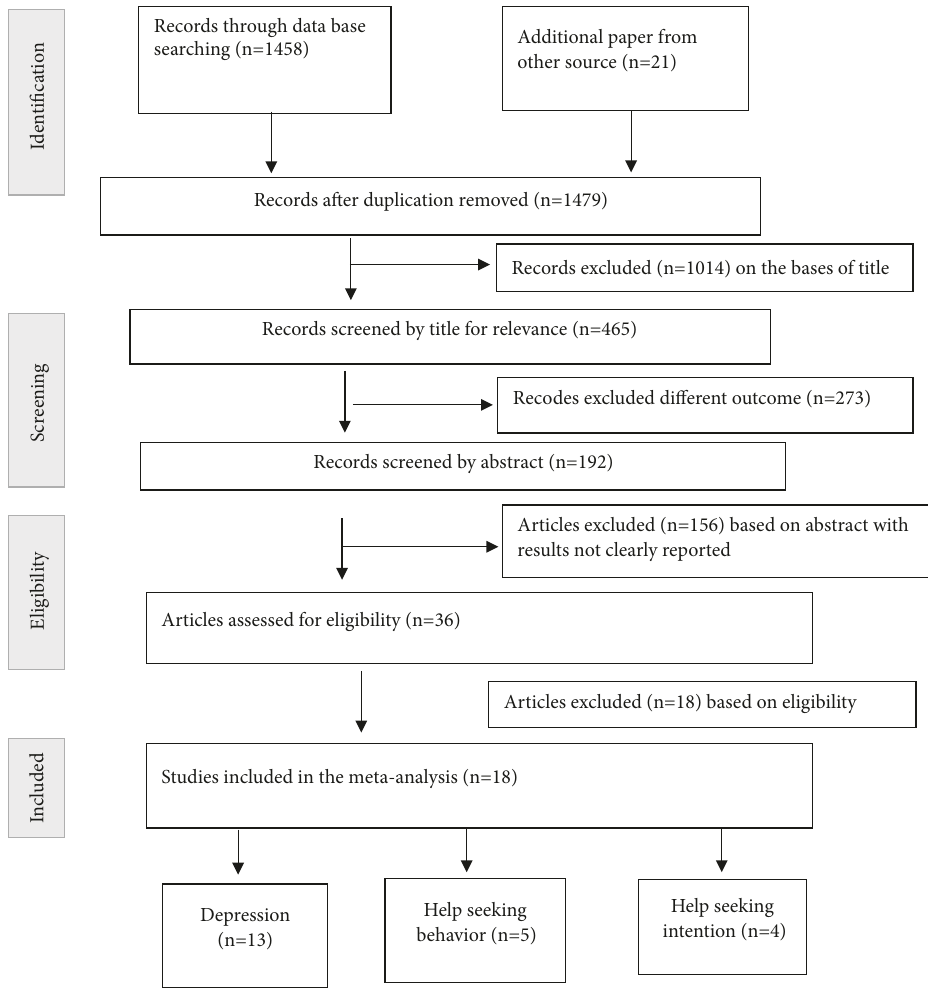
Figure 1: Flow diagram of the included